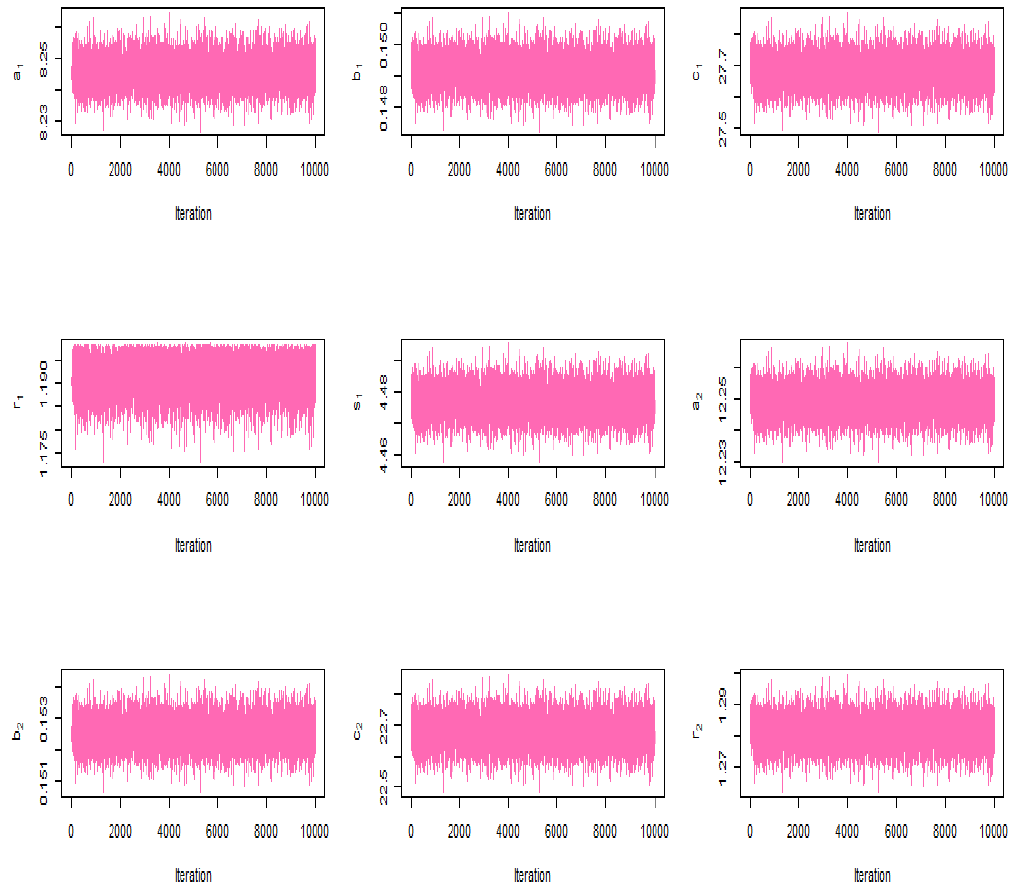
Figure 4. MCMC trace for results of Bayesian estimation of model for complete Bladder data for first 9 parameters.